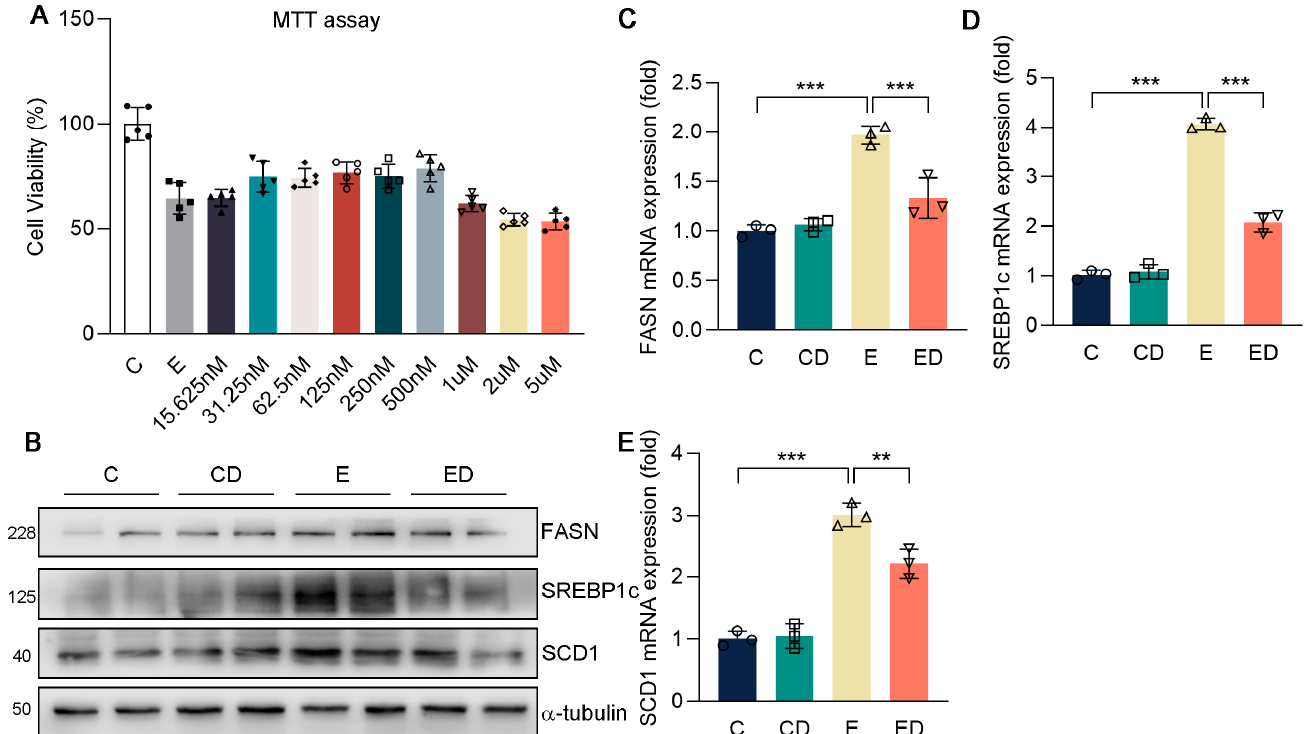
Figure 4. The effect of DAU on gene expression of lipid synthesis in HepG2 cells induced by alcohol. ( A ) MTT assay. ( B – E ) Protein and mRNA expression of FASN, SREBP1c, SCD1, COL1A1, COL3A1, and α − SMA in HepG2. Data are mean ± SD using one − way ANOVA ( n ≥ 3), ** p < 0.01, *** p <